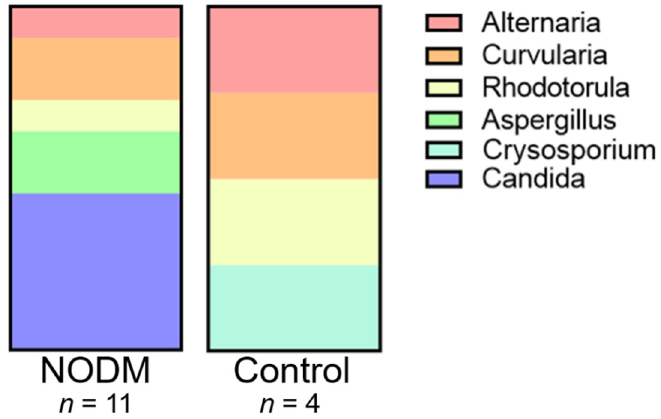
Figure 1. Relative distribution of fungal genera colonized from fecal cultures in dogs with naturally occurring diabetes mellitus and non-diabetic healthy controls.